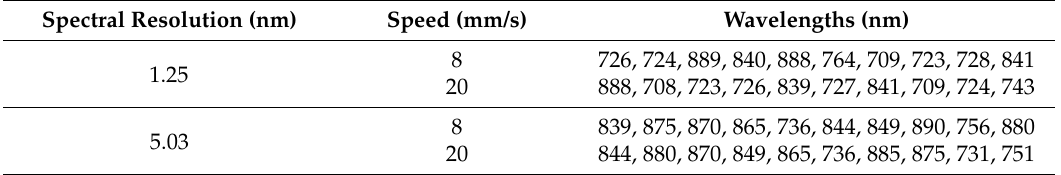
Table 1. The first ten selected wavelengths selected by random frog at different scanning speeds and spectral resolutions for chilling injury identification of green